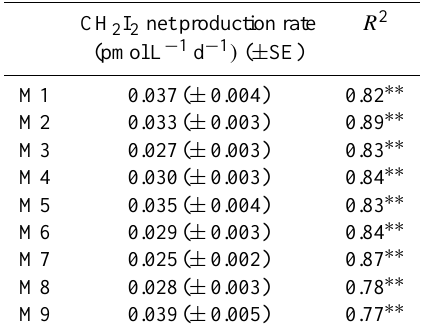
Table 4. CH 2 I 2 net production rates and coefficient of determina- tion ( R 2 ) of the linear regression for period t 4 – t 27 . Asterisks indi- cate associated probability: ∗∗ = p <